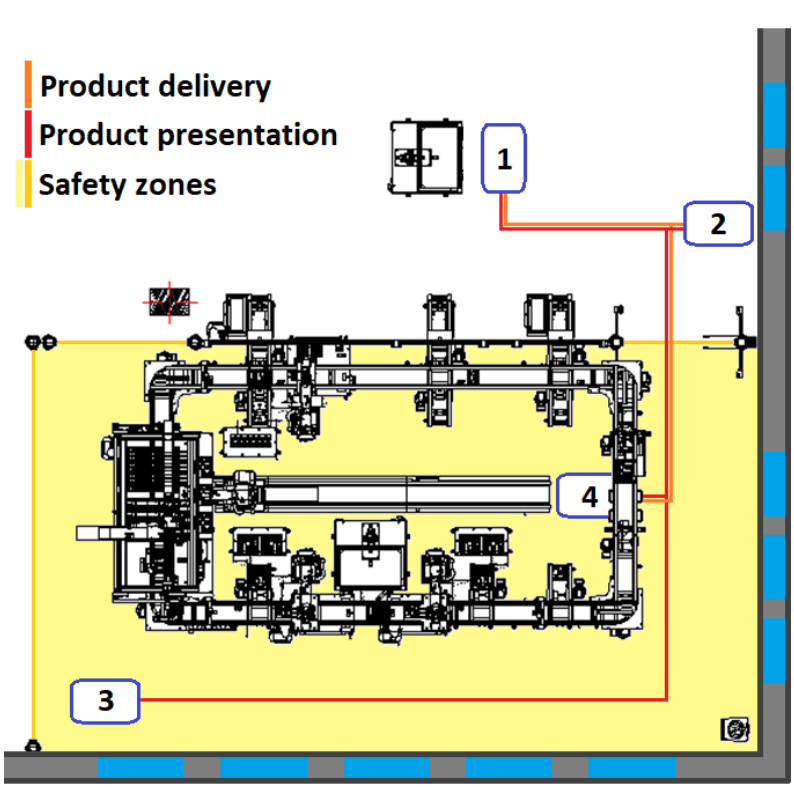
Figure 6. Delivery and presentation route of the product design. The block 1 represents the product delivery position, 2 represents the starting position, 3 represents the presentation position and in front of the windows, and 4 represents the product pickup position.